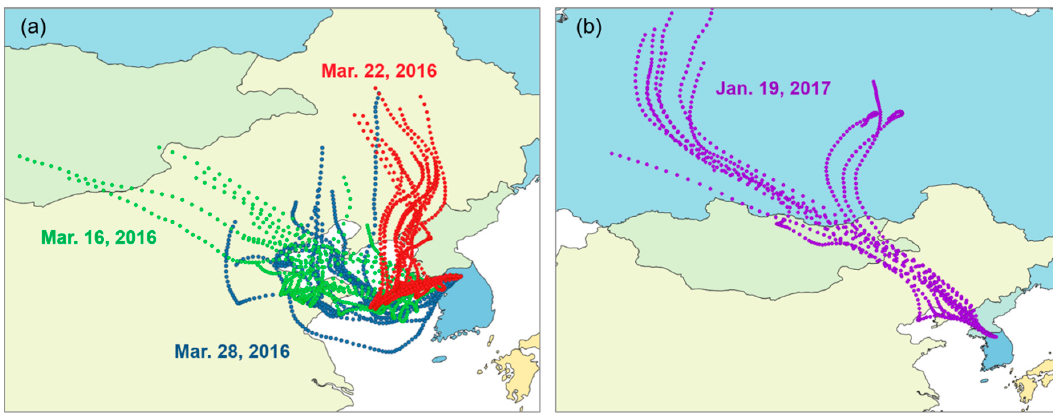
Figure 4. Back-trajectories for the high Na + samples obtained in ( a ) March 2016 and ( b ) January 2017.